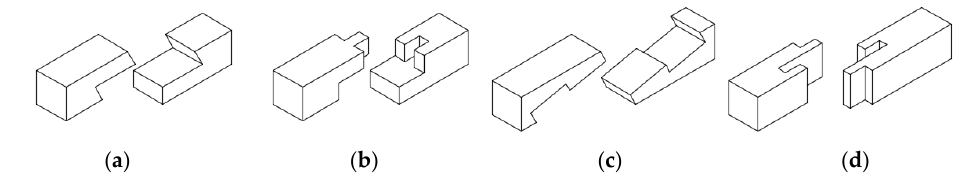
Figure 6. Scarf joints analysed in research: ( a ) under-squinted butt in halved scarf with two pegs, ( b ) side-halved and bridled with two pegs, ( c ) stop-splayed and tabled scarf with key and four pegs, ( d ) face-halved and bridled scarf with four pegs,